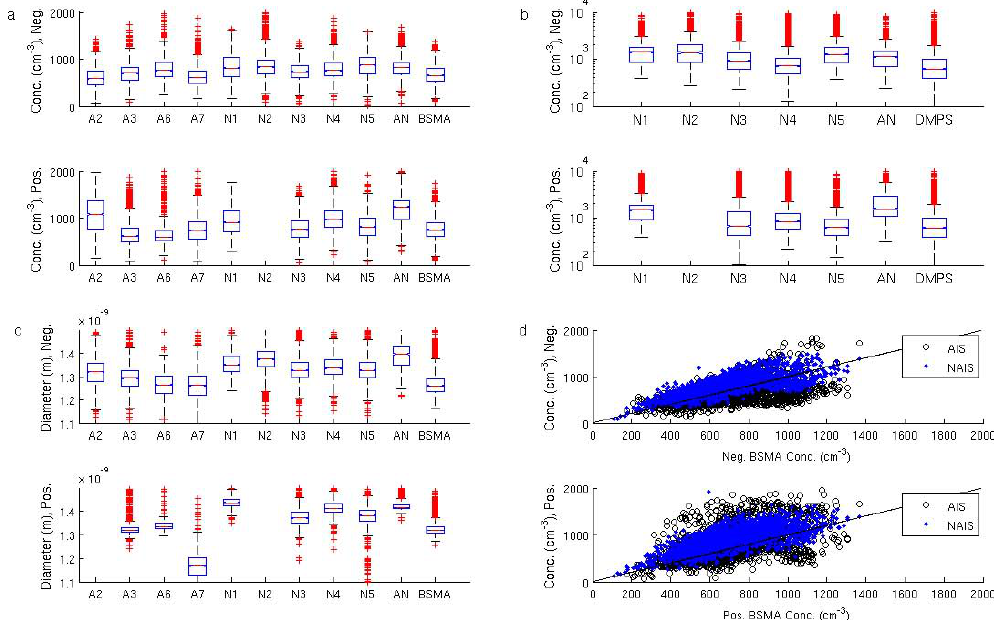
Fig. 7. Performance during the intercomparison period (7 June–25 June 2009). (a) Concentration of ions for AISs, NAISs and the BSMA (size range: 3–7nm). (b) Concentration of particles for NAISs and the DMPS (size range: 10–40nm). (c) Mean diameter for AISs, NAISs and the BSMA (0.8–3nm). The red lines are the median value, the blue boxes are the 25-th and 75-th percentile, whiskers are 10-th and 90-th percentiles and red crosses are outliers. For readability purposes, the AISs are coded “A” and the NAISs, “N”. The ANAIS is coded AN. (d) The total ion concentration of the ion spectrometers in the 3–7nm size range is compared to the BSMA concentration. The AISs are represented by black circles and the NAISs by blue